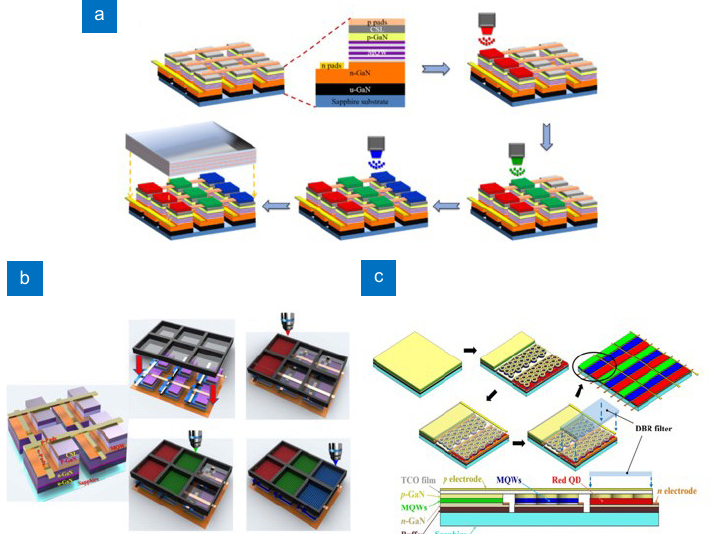
Fig. 4 | ( a ) Schematic diagram of AJP process. ( b ) Processes of fabricating the full-color micro-LED display based on lithography and AJP tech- nique. ( c ) Full-color design of QD-NR-Micro-LED display. Figure reproduced with permission from: (a) ref. 16 , The Optical Society; (b) ref. 41 , (c) ref. 15 , Chinese Laser